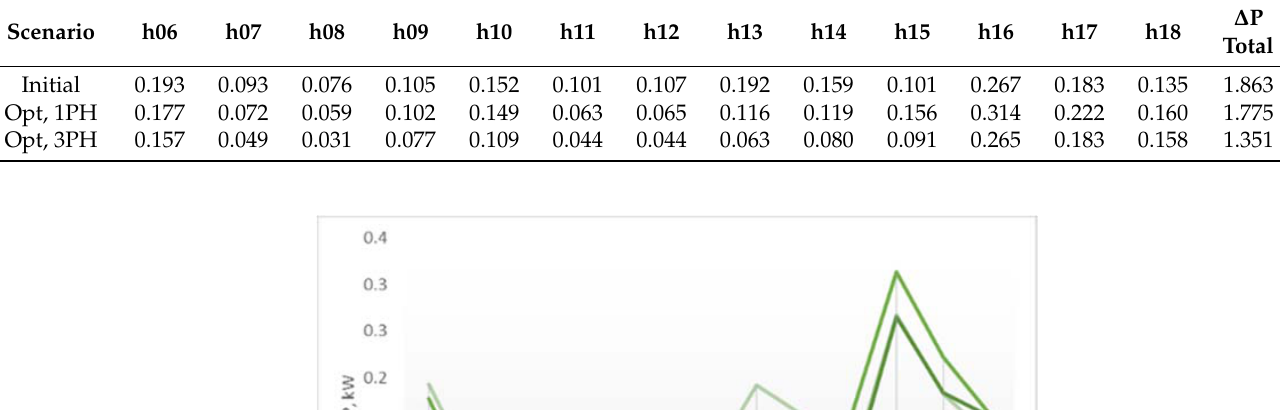
Table 8. Power losses in network R121, hourly and total, in the interval 06:00–18:00, kW.